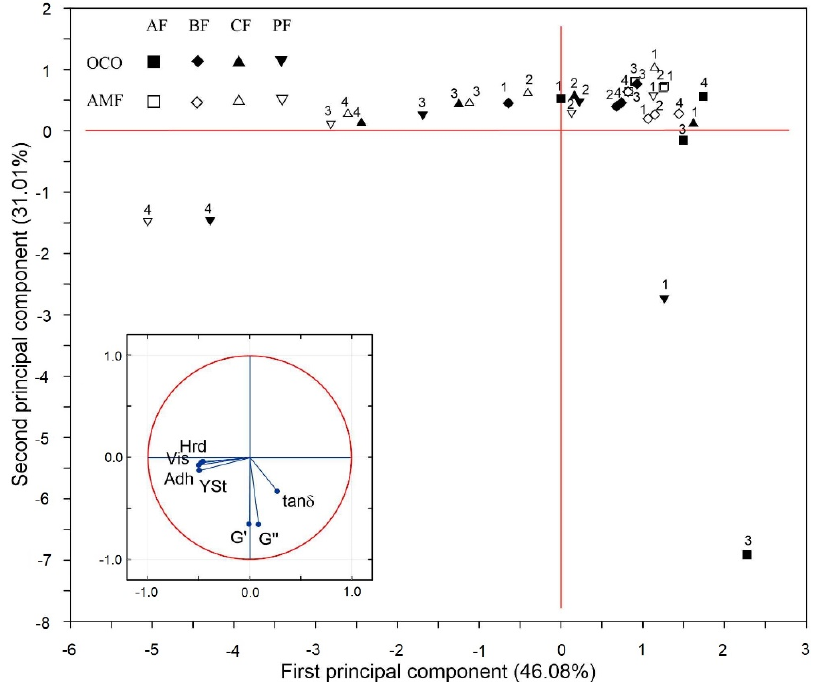
Figure 4. Principal component analysis (PCA) bi-plot for physical properties parameters (Hrd: hardness, Adh: adhesiveness, Vis: viscosity, YSt: yield stress, G ′ : storage modulus, G ″ : loss modulus, tan ( δ ): loss tangent) of acid casein PCS with different type of fat/oil (AFM or OCO), type of fiber (AF, BF, CF, PF) and fiber concentration (1%, 2%, 3%, 4%). Inset: correlation circle between variables all of the original variables included in a PCA in the first and second principal component factorial plane (correlation biplot).